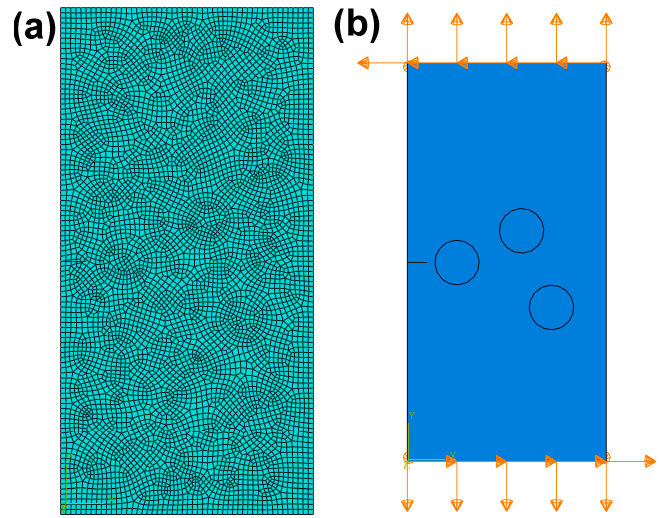
Figure 9. ( a ) Finite element mesh and ( b ) boundary conditions for the composite of SiC particles-reinforced Ti 3 SiC 2 .